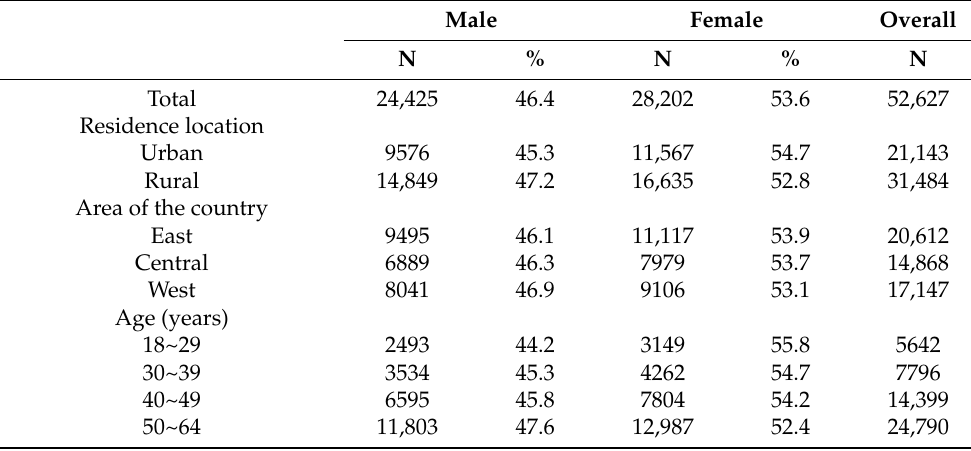
Table 1. Demographic and clinical characteristics of all